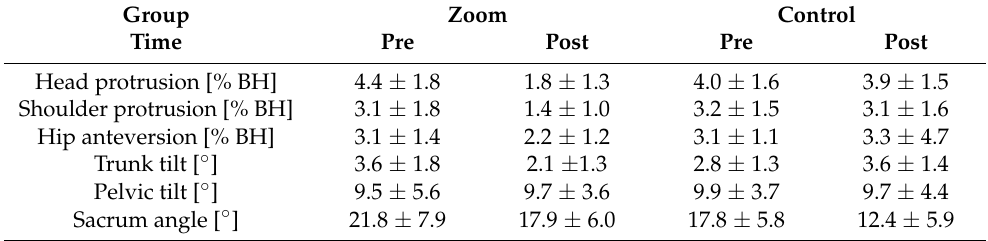
Table 4. Development of the posture parameters over time (mean ± standard deviation).